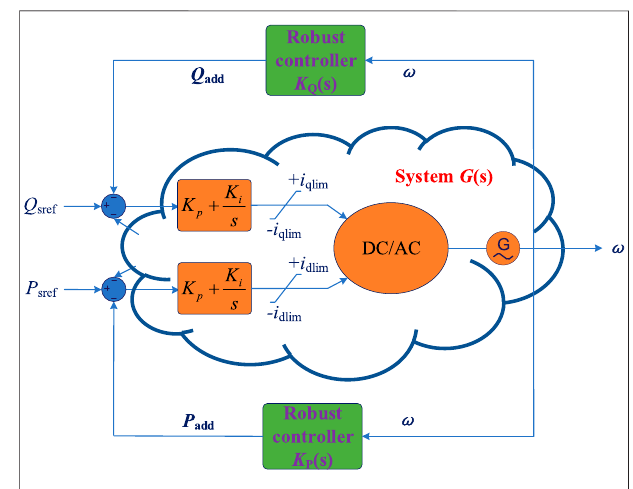
FIGURE 8 | Uni fi ed robust control scheme based on the LMI method and TLS-ESPRIT